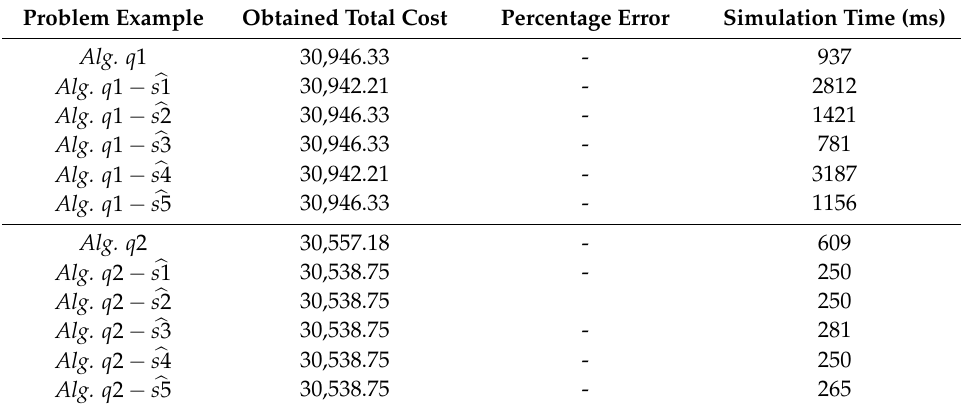
Table 9. Obtained results for irregular network GIr-2 (suboptimal